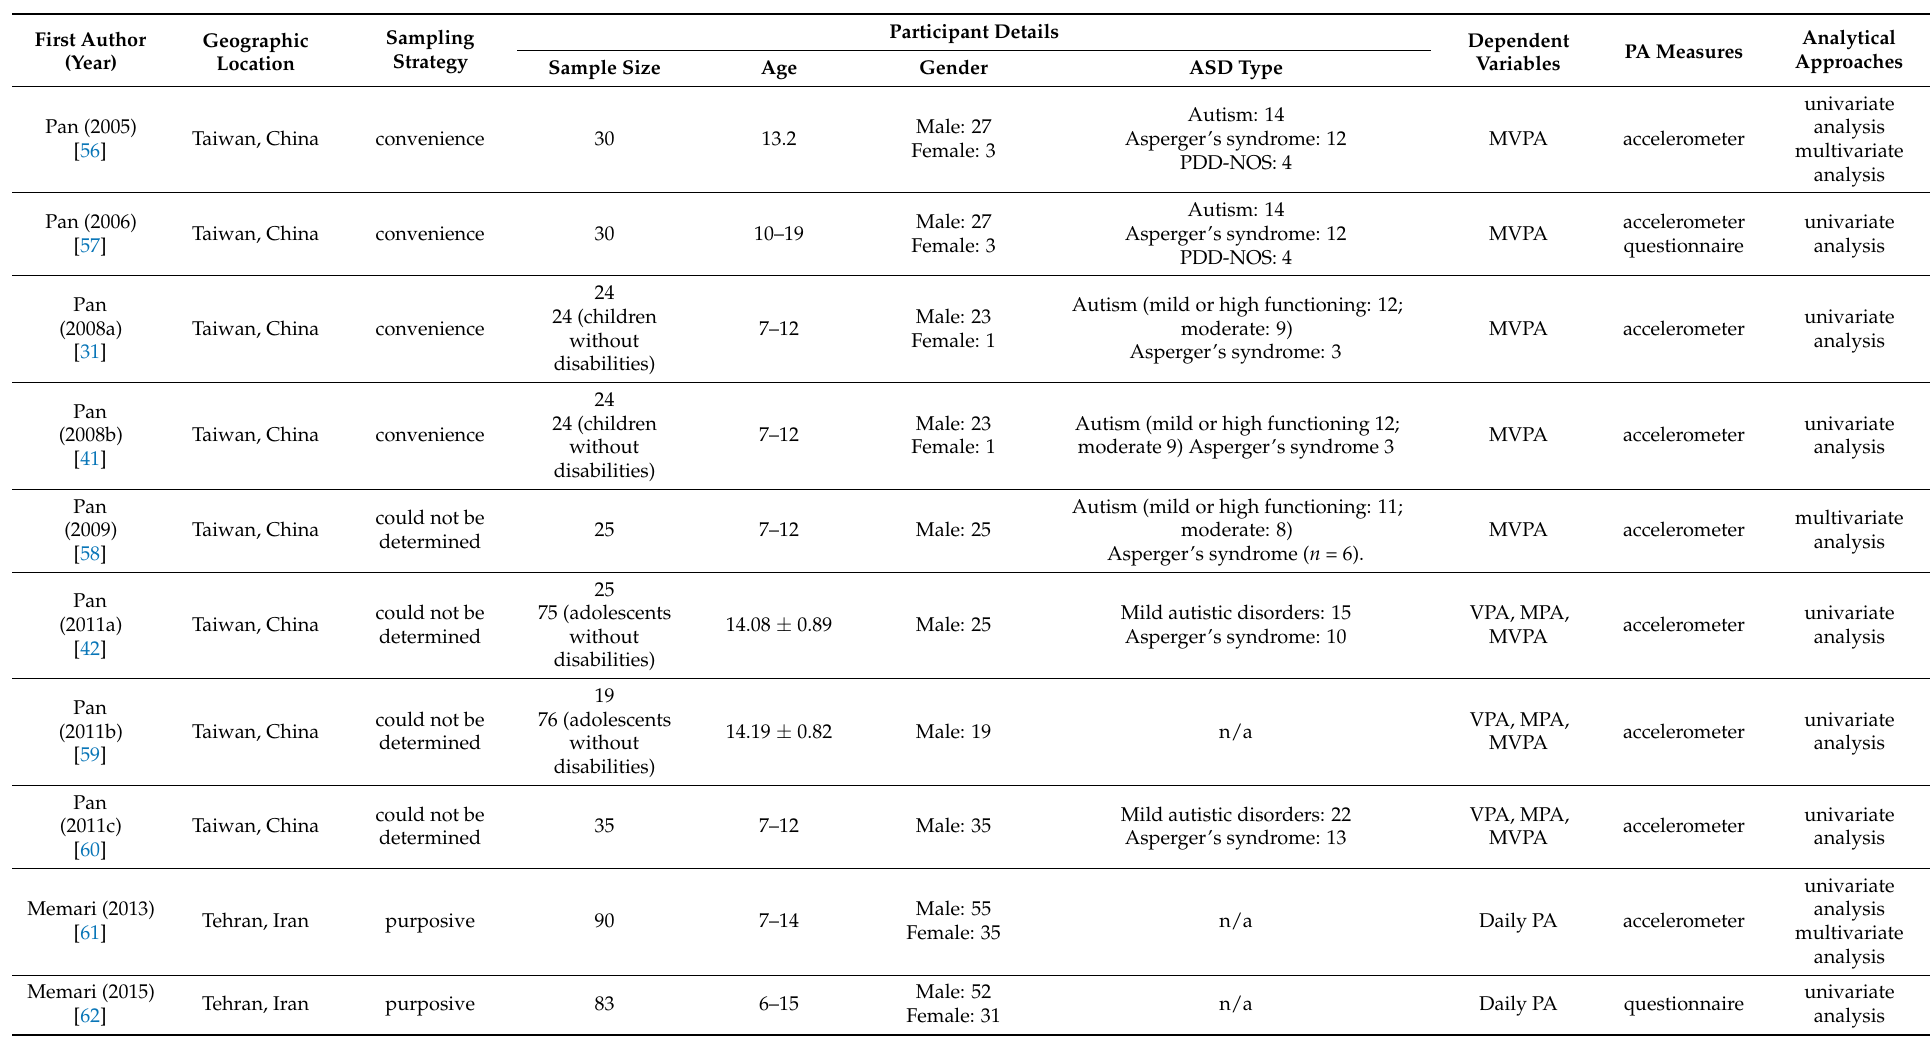
Table 1. Descriptive statistics of included